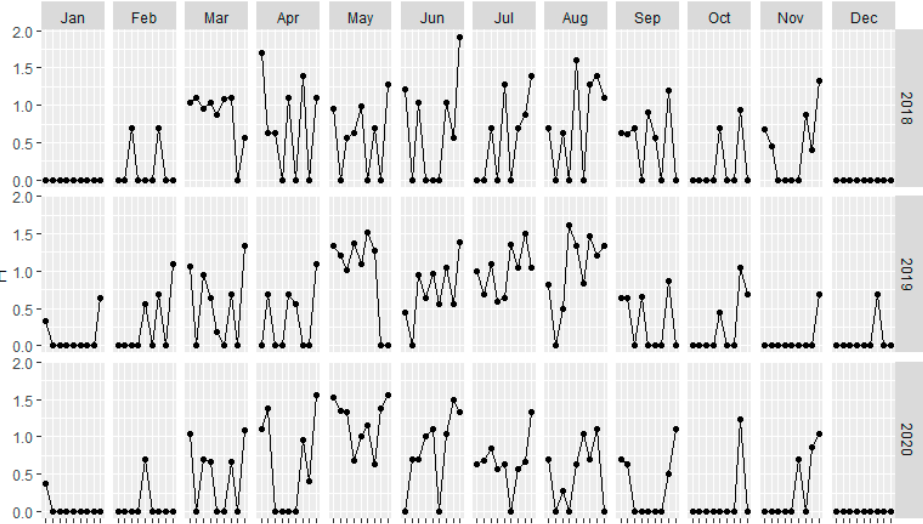
Figure 4. Monthly Shannon diversity of birds within the riparian area of Ruby Run at the JW Ruby Research Farm, Reedsville, West Virginia, USA, from 2018 to 2020. Birds were recorded in five equidistant 50 m radius point counts along the stream as well as along transects between each point count area. Lines are plotted to show trends in diversity from downstream to upstream.